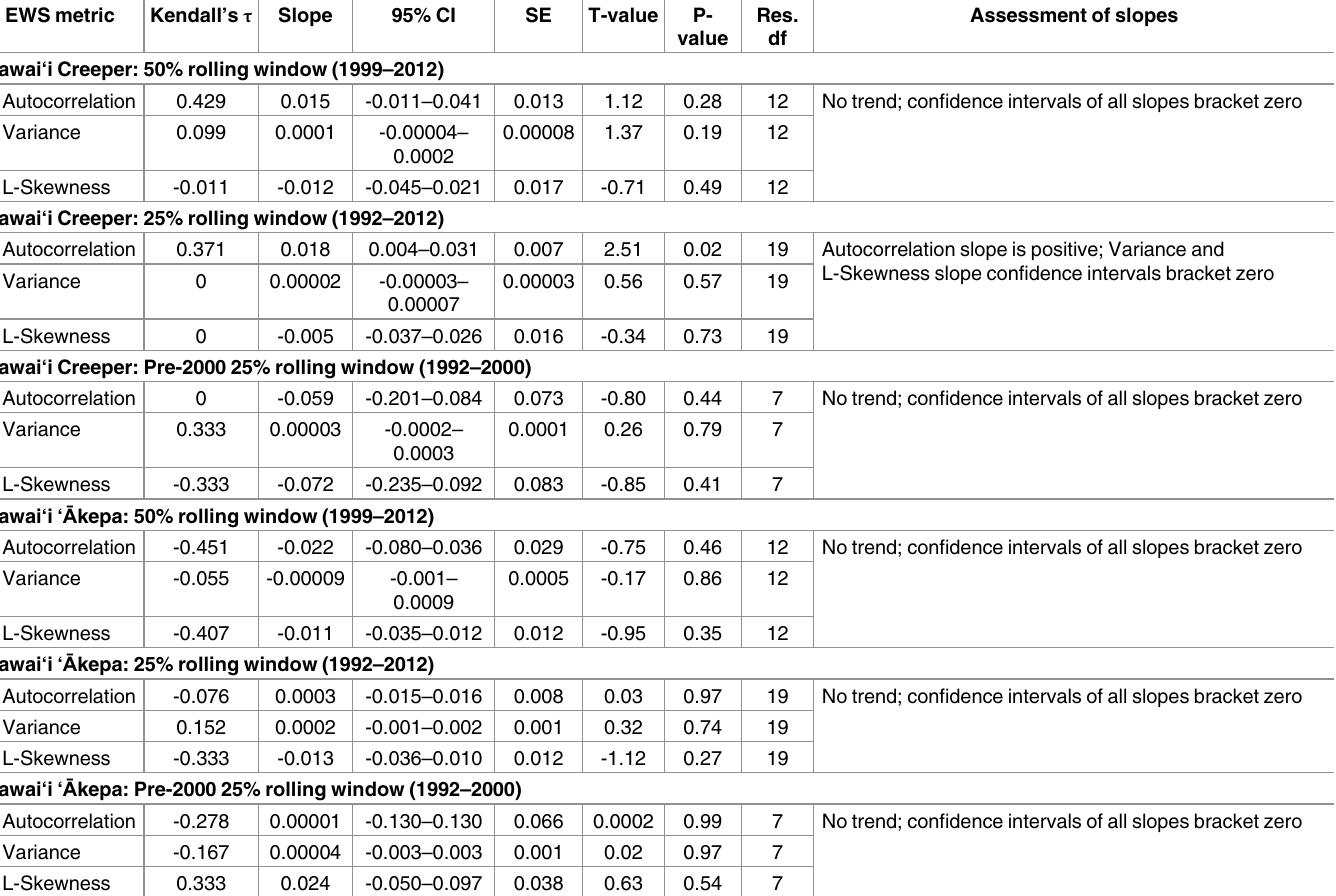
Table 1. Kendall’s τ and linear trends of the early warning signals autocorrelation, sample variance, and linear skewnessin the Hawai‘i Creeper and Hawai‘i ‘ Ā kepausing state-space abundance estimatesin